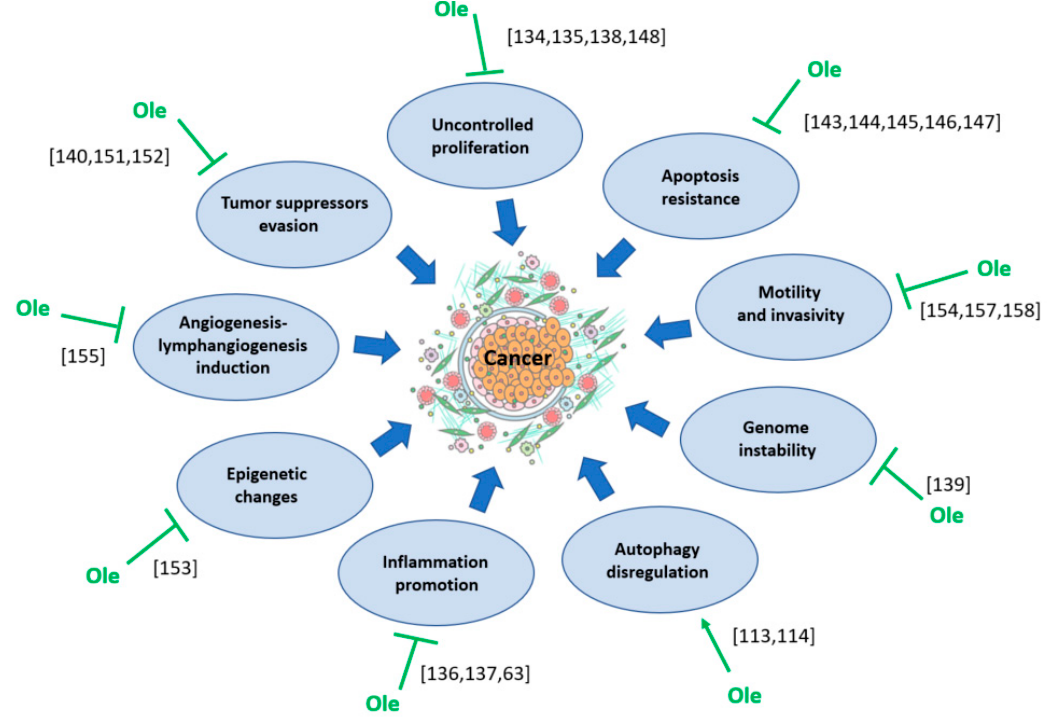
Figure 3. Effect of oleuropein (Ole) on the factors contributing to cancer development. Figure 3. E ff ect of oleuropein (Ole) on the factors contributing to cancer